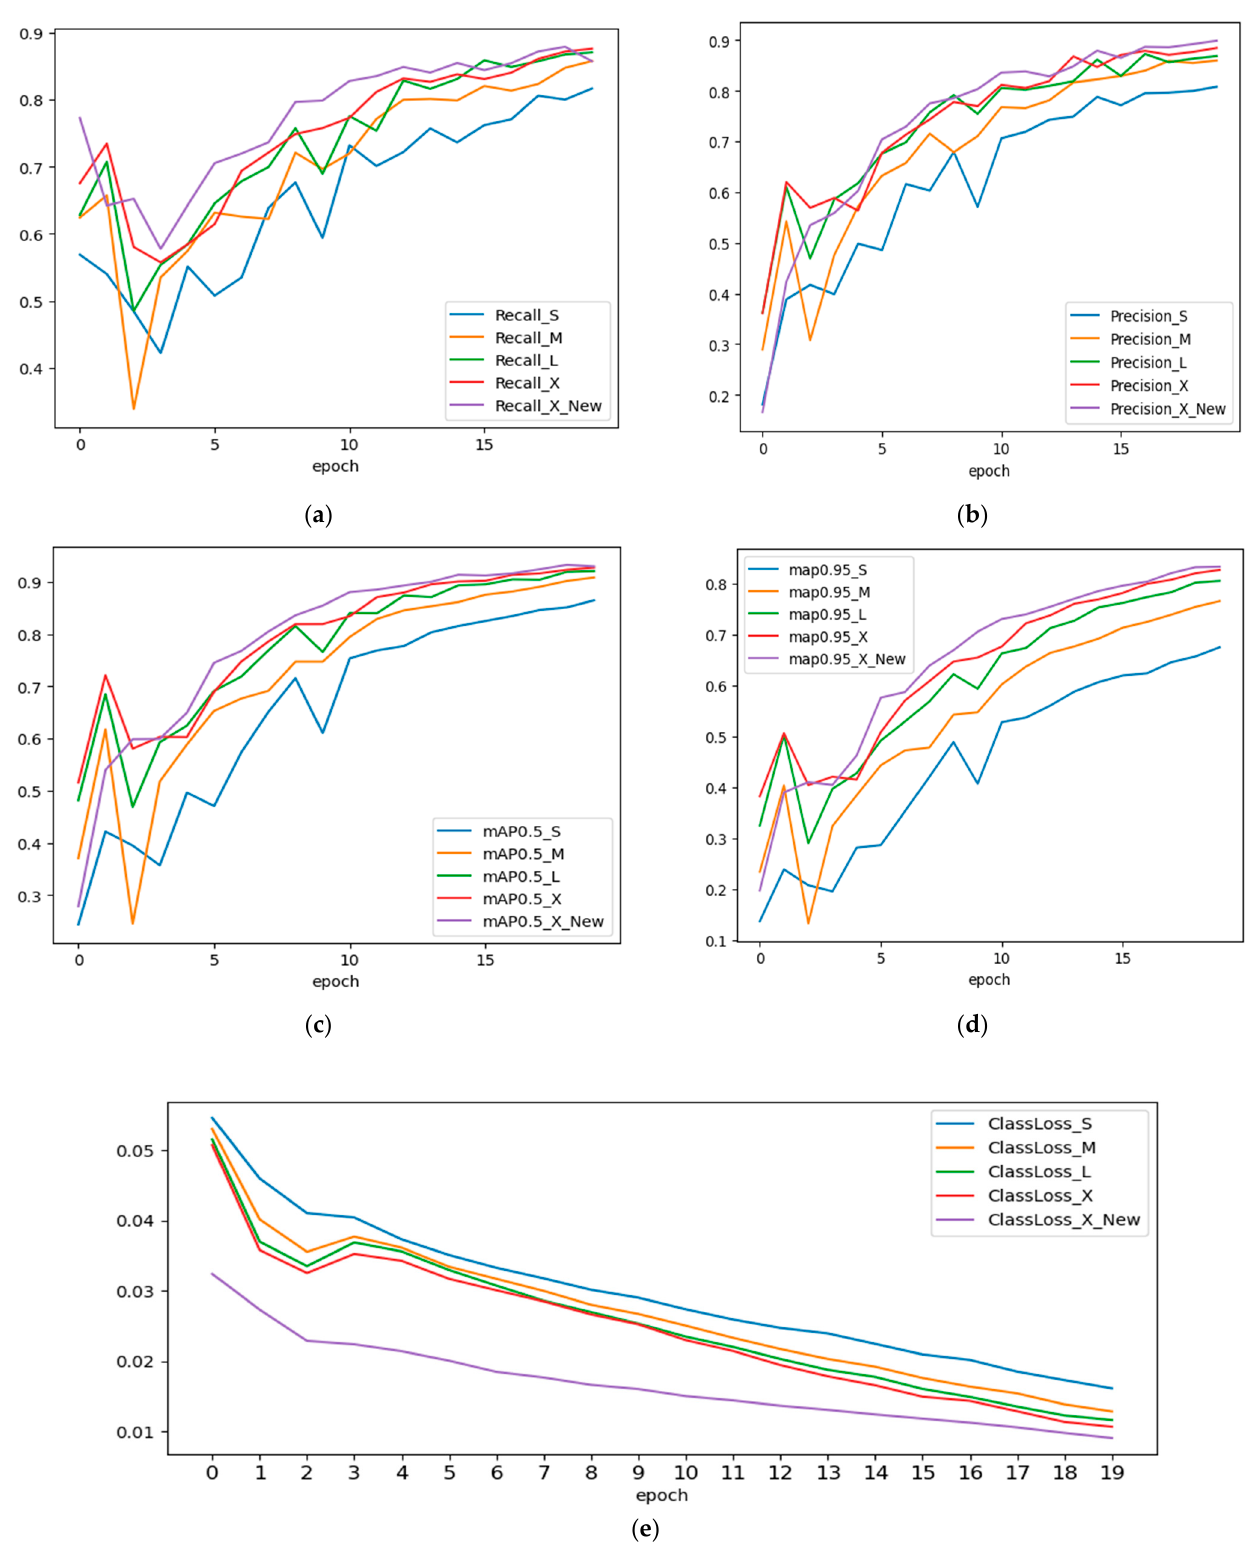
Figure 6. ( a ) Precision, ( b ) recall, ( c ) mAP@0.5 ( d ) mAP@0.95 and ( e ) loss curves of models used in experimental study.